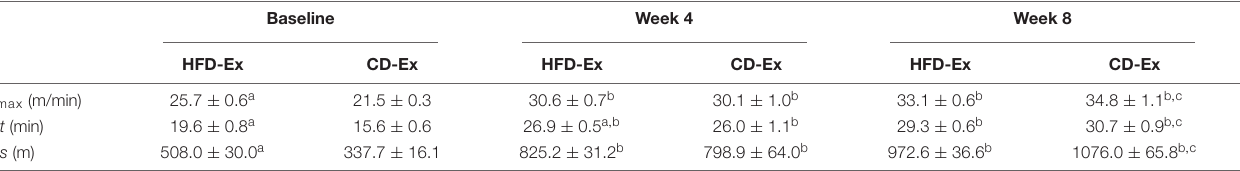
TABLE 1 | Maximal incremental exercise